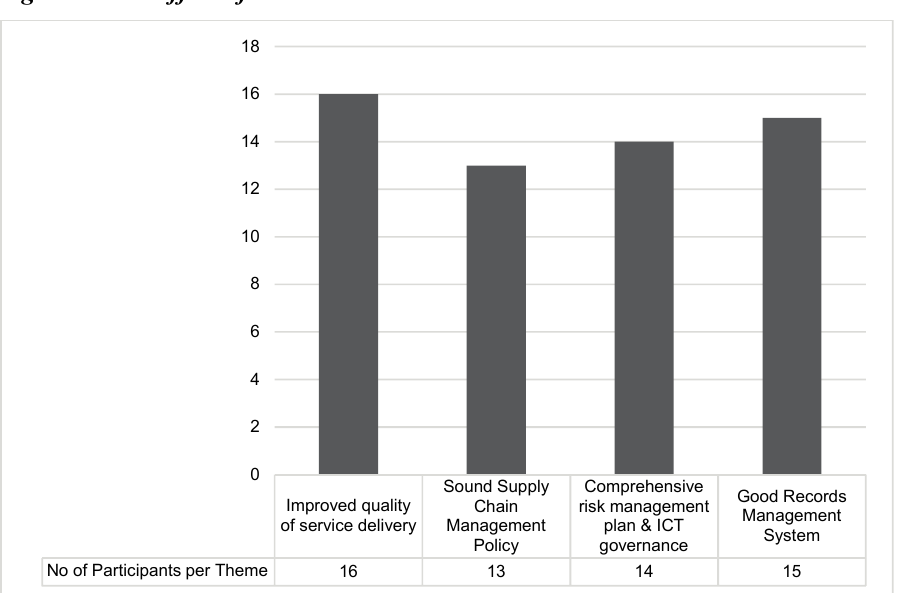
Figure 5: The effect of Internal